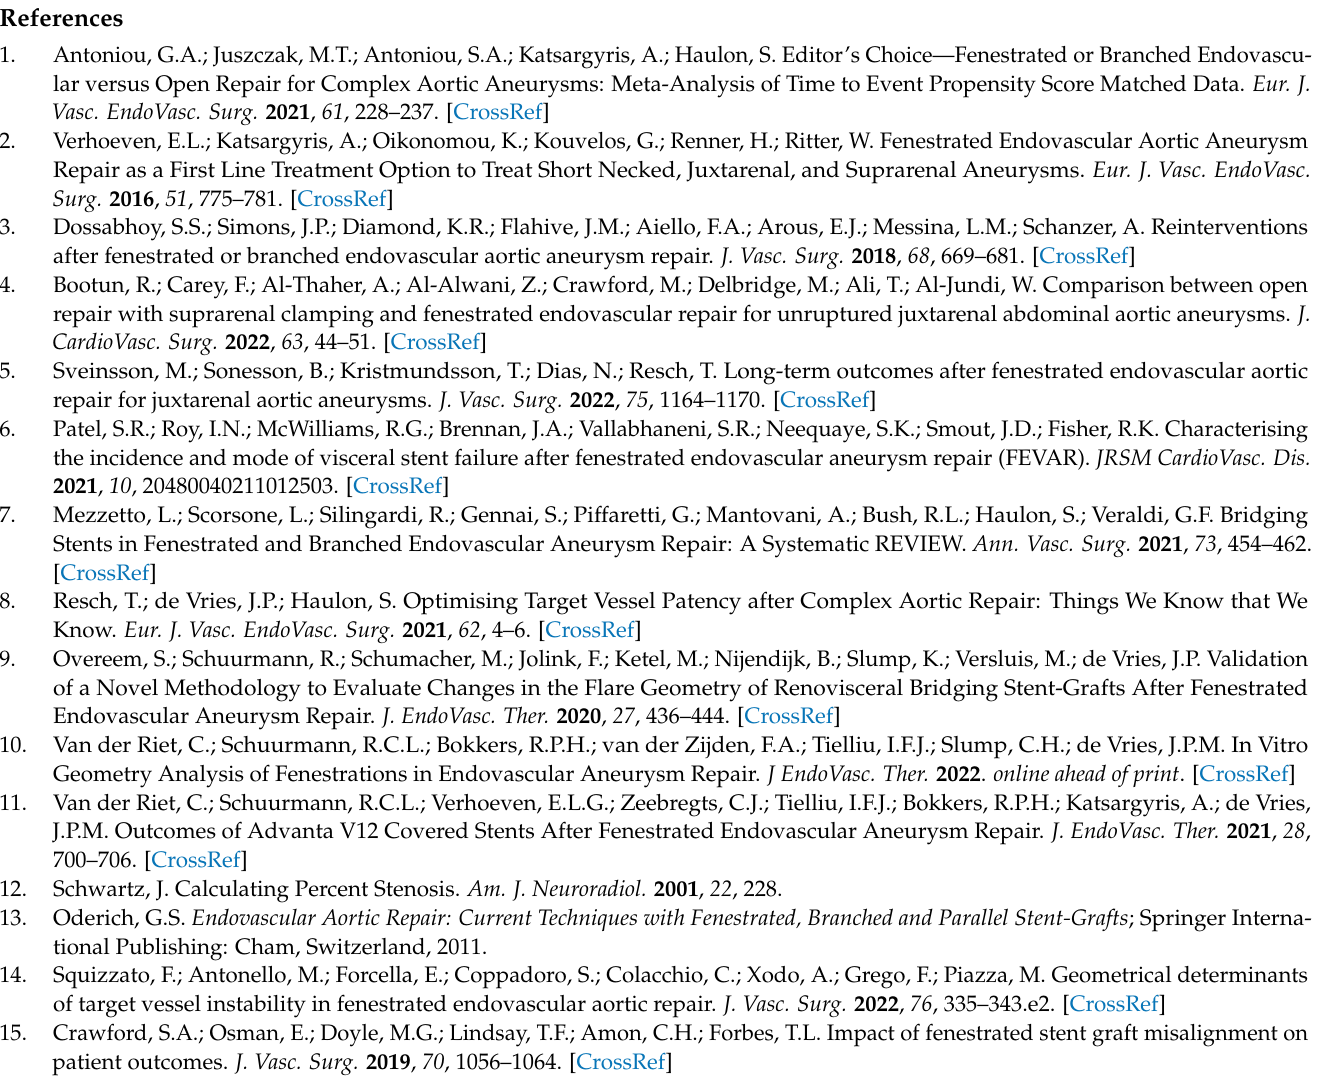
Figure A1. Kaplan–Meier curves for freedom from Advanta V12 balloon-expandable covered stent (BECS)-associated complication and reintervention. FEVAR, fenestrated endovascular aneurysm re ‐ pair.